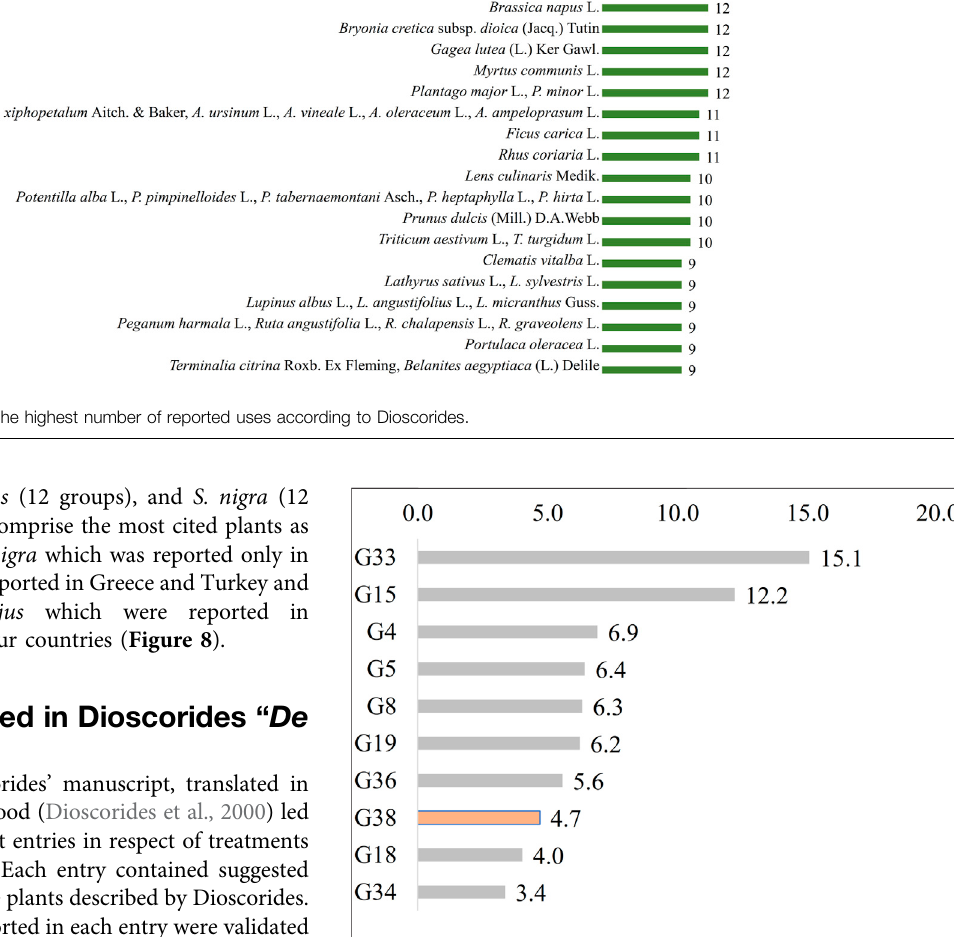
Frontiers in Pharmacology |